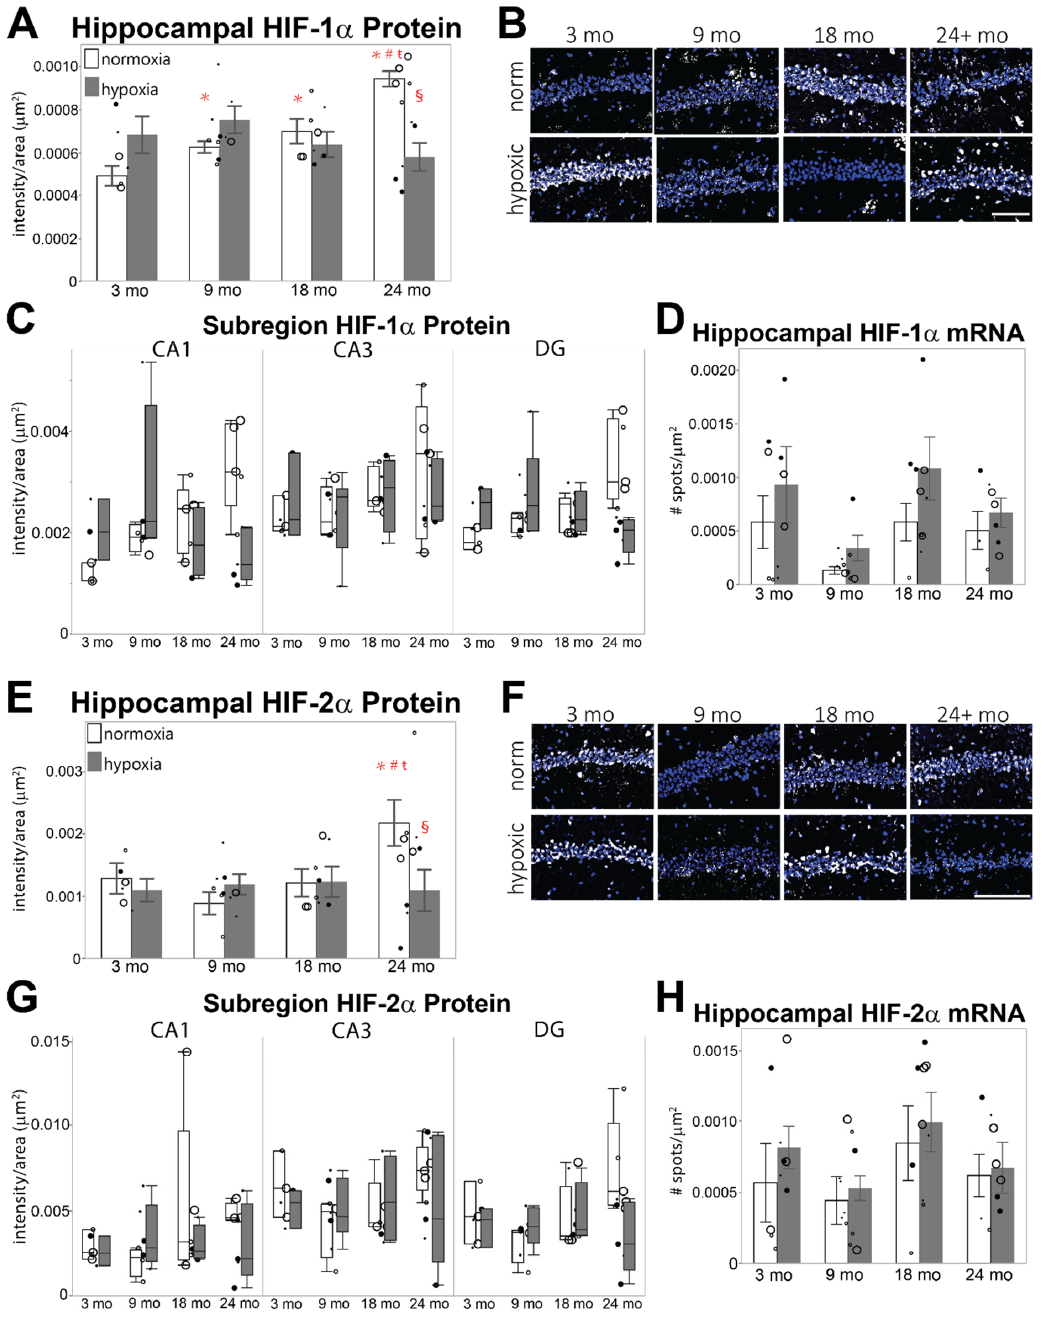
Figure 4. Hippocampal HIF- α protein levels associated with hypoxia. Comparison of HIF-1 α and HIF-2 α levels in the hippocampus of male (large dot) and female (small dot) mice exposed to room air (normoxic; open circles) or 3% oxygen for 3 h (hypoxia; filled circles). ( A , E ) HIF-1 α ( A ) and HIF-2 α ( E ) mean intensity/ µ m 2 in total hippocampus of different aged mice exposed to room air or hypoxia. ( B , F ) Representative images of HIF-1 α ( B ) or HIF-2 α ( F ) (illustrated in white) merged with DAPI (blue) in the hippocampus of different aged mice exposed to room air or hypoxia. ( C , G ) HIF-1 α ( C ) or HIF-2 α ( G ) protein measured as intensity/ µ m 2 within hippocampal subregions (CA3, CA1, and dentate gyrus [DG]) of different aged mice exposed to room air or hypoxia. ( D , H ) mRNA levels of HIF-1 α ( D ) or HIF-2 α ( H ) measured by fISH in sections from the same aged mice exposed to room air or hypoxia. Results are reported as the number of spots counted per µ m 2 . Scale bar = 150 µ m; p ≤ 0.05; * = compared to 3 mo normoxic control; # = compared to 9 mo; = compared to 18 mo; § = interaction between age and